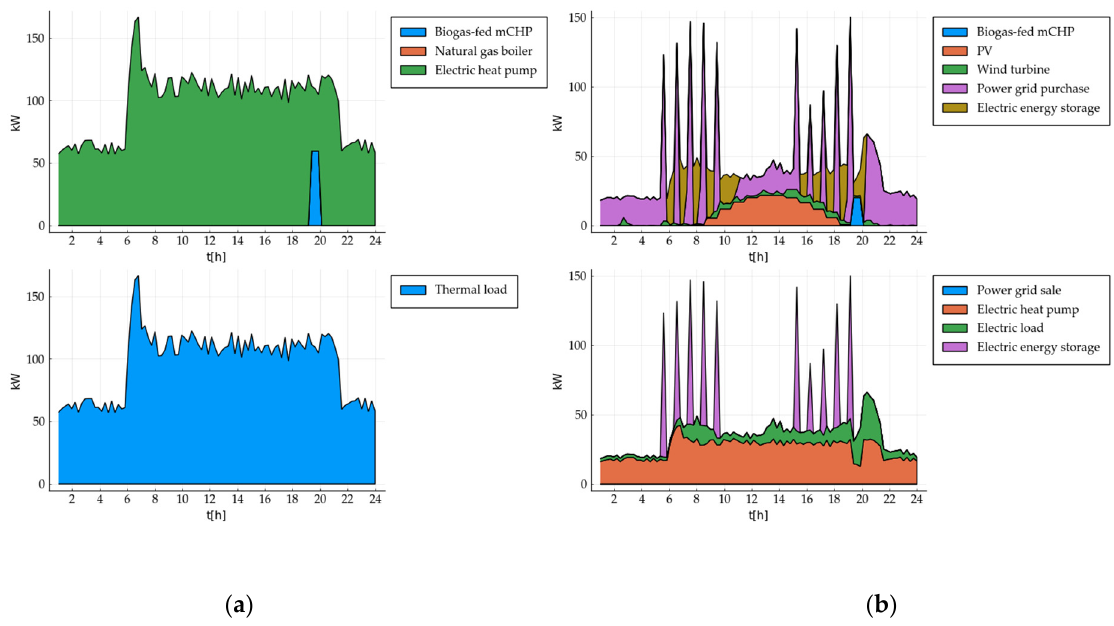
Figure 13. Daily consumption and production pattern for Case 2 (Operation Optimization) with a biogas price of 0.39 €/m 3 : thermal production ( a -up) consumption ( a -down); electricity production ( b -up) consumption ( b -down).